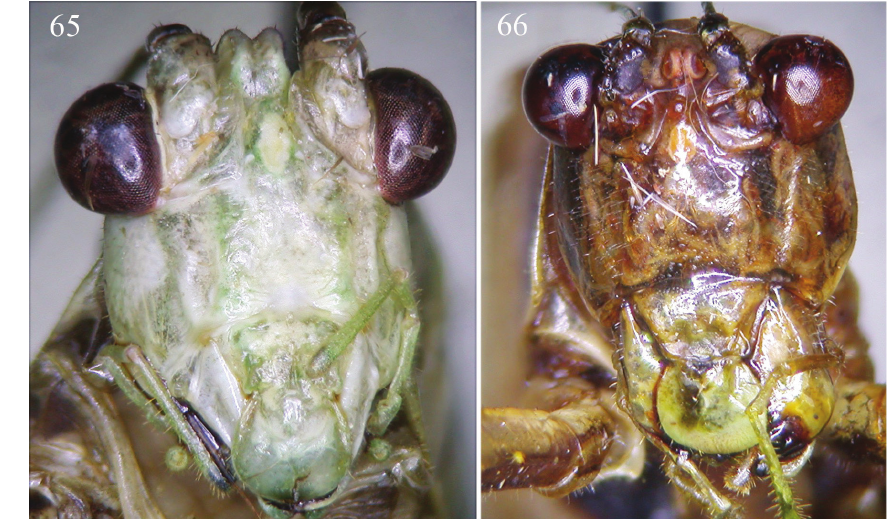
Figs 65–66. Tetraconcha aristophanousi : 65. Male, face in frontal view; 66. Female, face in frontal